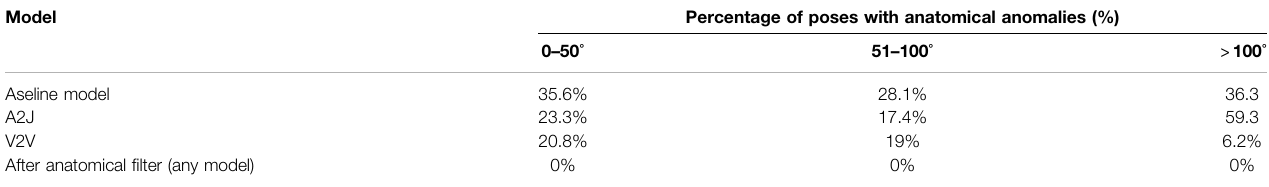
TABLE 2 | Percentage of poses with anatomical anomalies at the speci fi ed ranges, comparing the baseline model with the state-of-the-art models. The test was performed on a subset of 20000 test images of the HANDS2017 dataset.